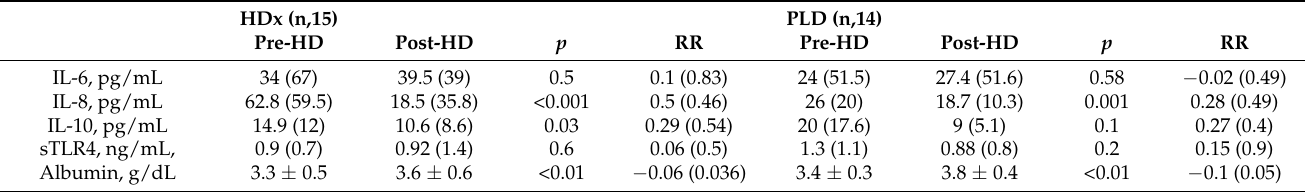
Table 2. Effects of a single treatment with different dialysis membranes on cytokine removal in maintenance HD patients affected by